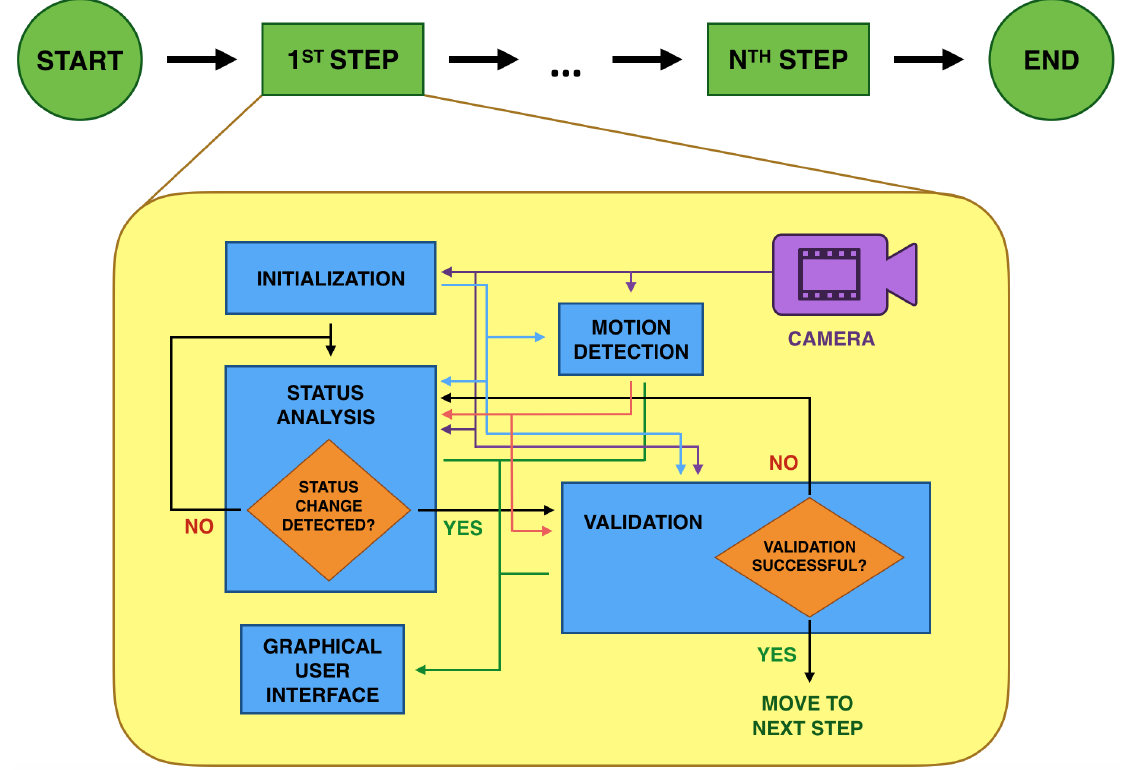
Figure 4. Workflow of the proposed validation